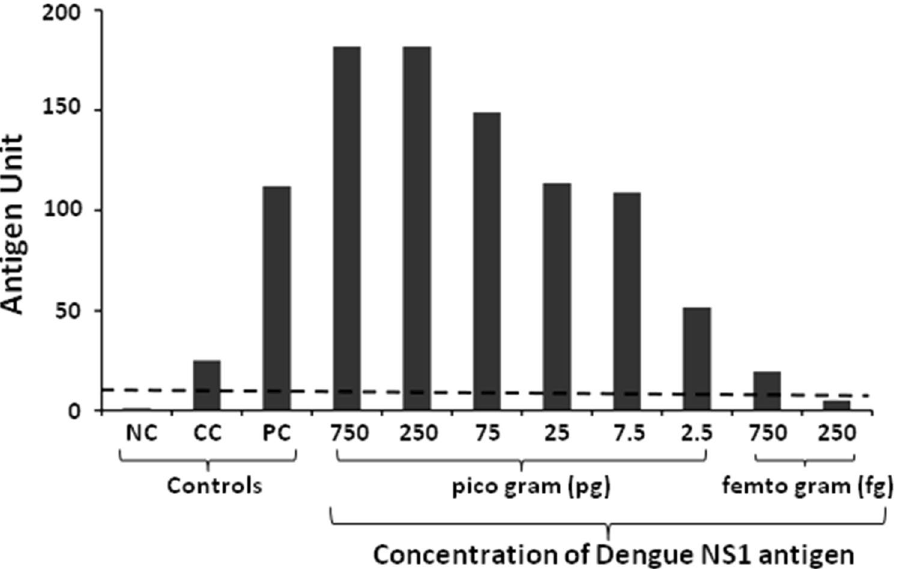
Figure 2. Determination of rDENV-2 NS1 detection limit of dengue NS1 Ag Microlisa kit. Recombinant Dengue NS1 antigen at different concentration was added to the wells of Microlisa plate and the assay was performed as per the instructions of the manufacturer. Absorbance was read at 450 nm in ELISA reader. NC Negative control, CC Calibrator control, PC Positive control. Dotted horizontal line indicates the cut-off value.